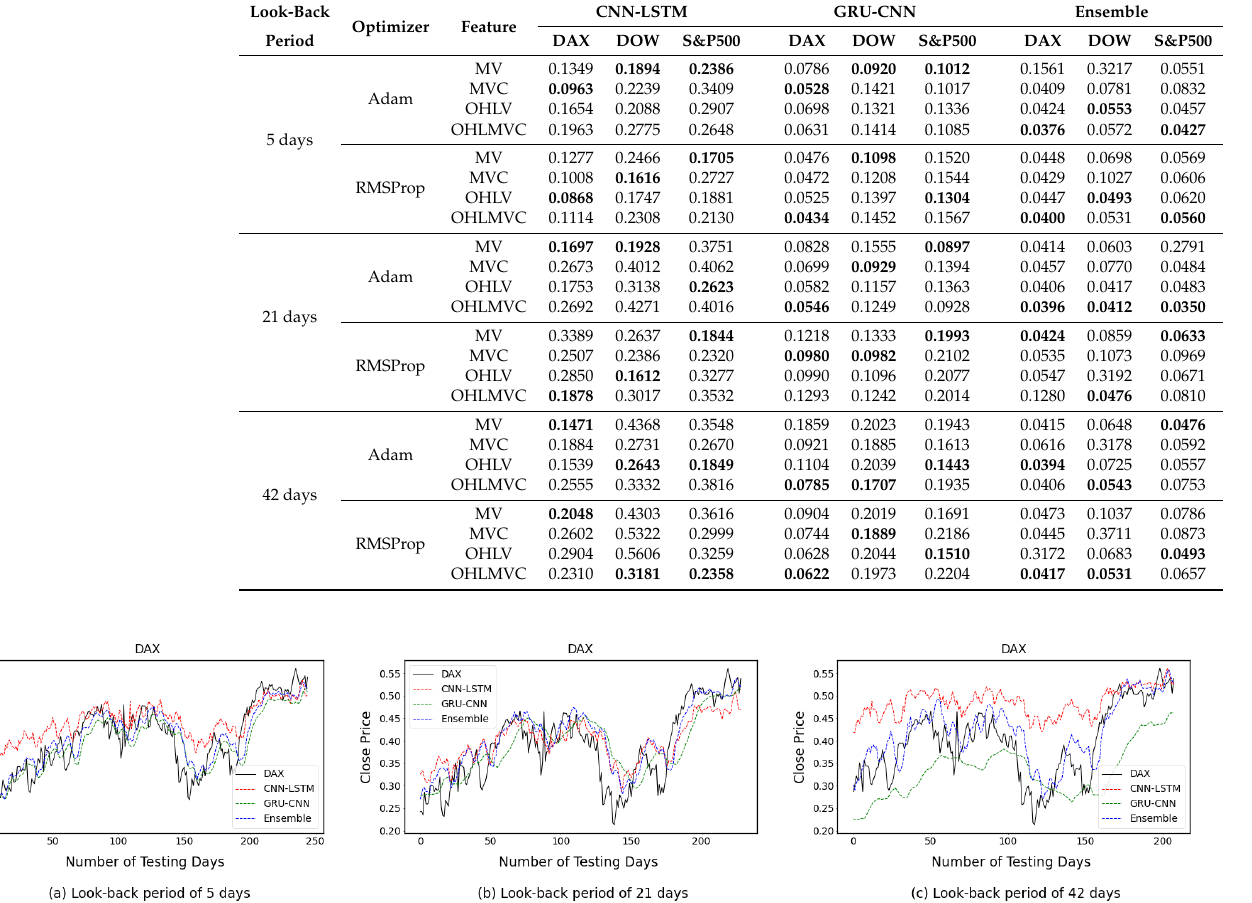
Figure 9. Comparison of true and predicted close prices of the DAX index between different look-back periods for five-time-step prediction over the period from 24 October 2014 through 31 December 2019.